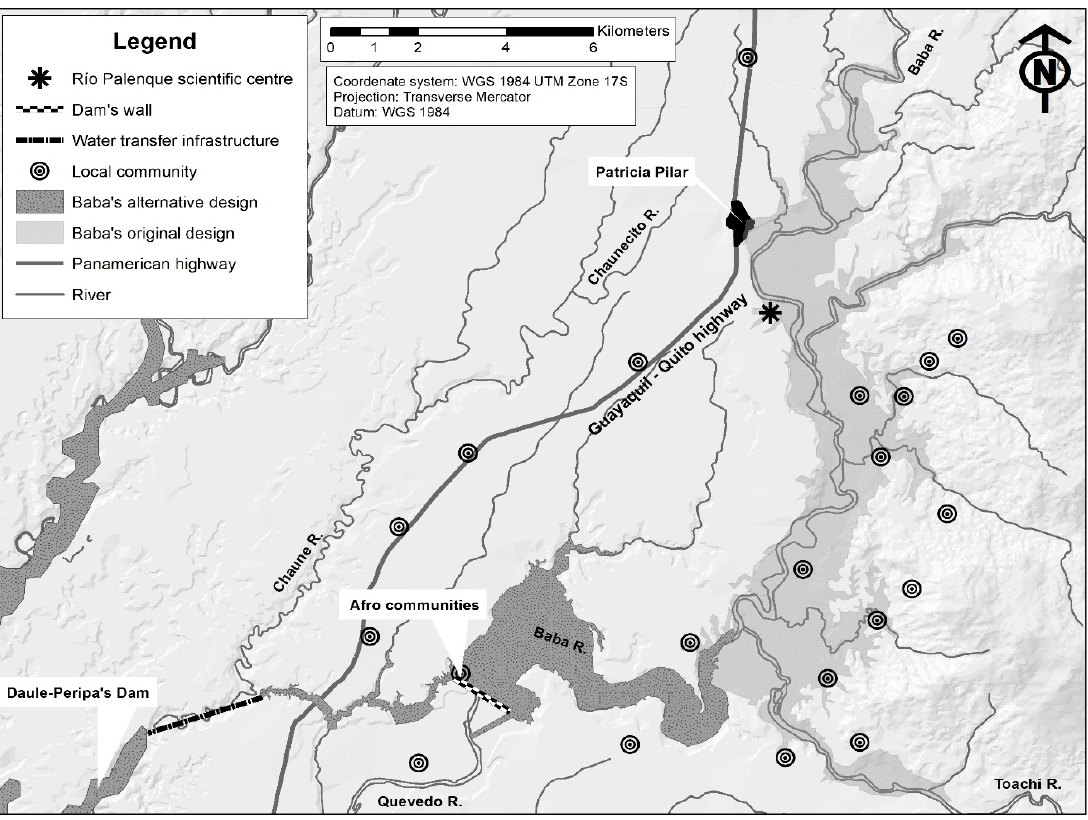
Figure 4. Baba dam’s alternative design and affected Afro-Ecuadorian communities. Source: HidroPacífico S.A. Prepared by: the authors.